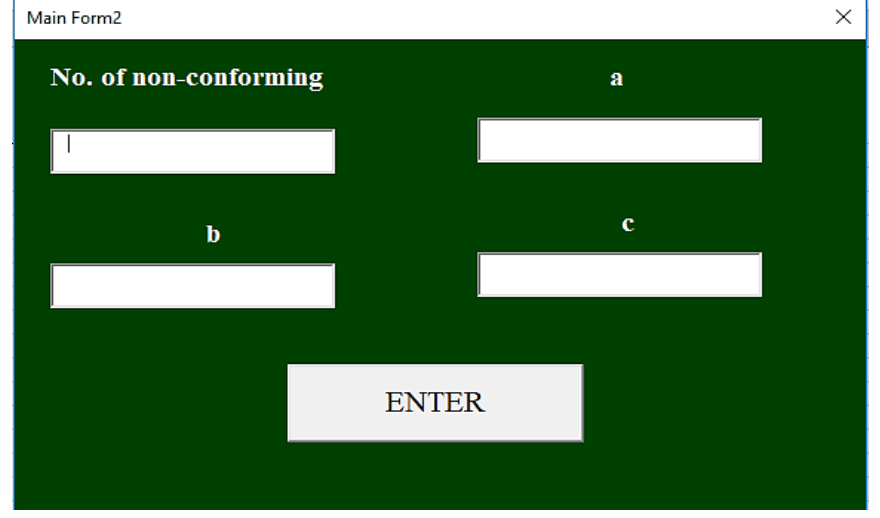
Figure 2. Input Box.